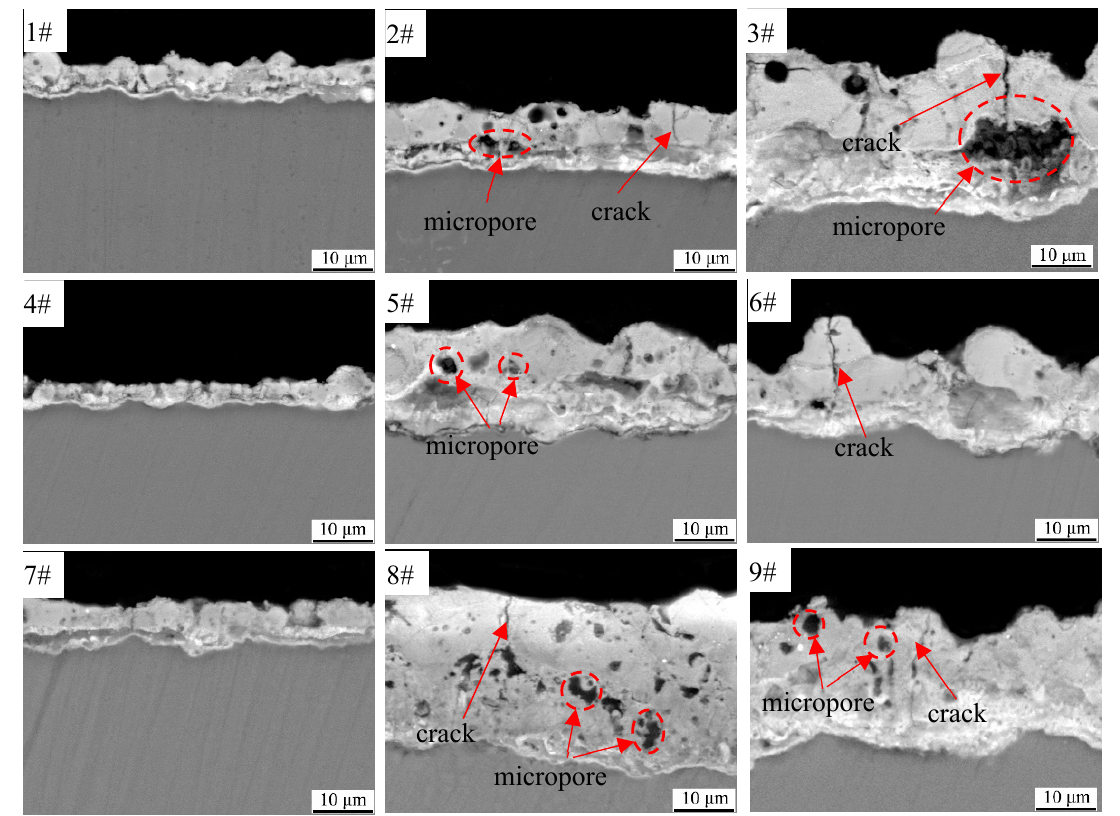
Figure 5. Cross-sectional morphologies of black MAO coating samples 1 # − 9 # . The SEM cross-sectional micrographs and corresponding elemental distribution of sample 5 # are shown in Figure 6. It is clearly observed that in the coating, the main elements are Al, Mg, O, Cu, F and W. The presence of Mg originates from the substrate, whereas O, Cu, F, W and most of Al are originated from the electrolyte. As can be seen, each element possessed a relatively uniform distribution across the sample section.